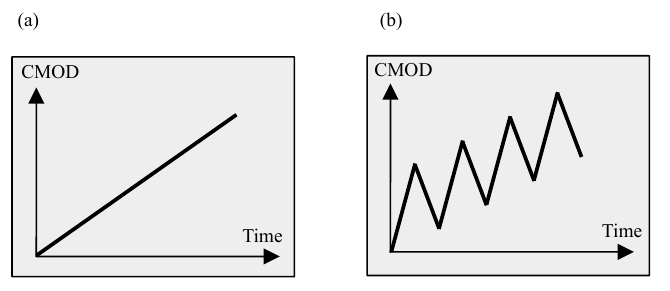
Figure 5. Typical loading scenarios of the studied tested beams: ( a ) monotonic behavior, ( b ) cyclic